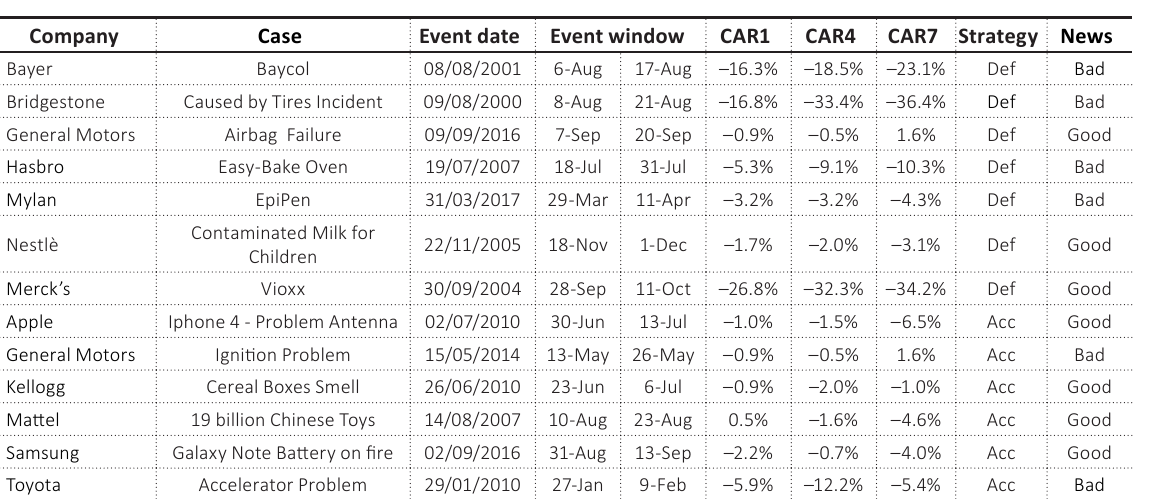
Table A5. Product recall. Shock event